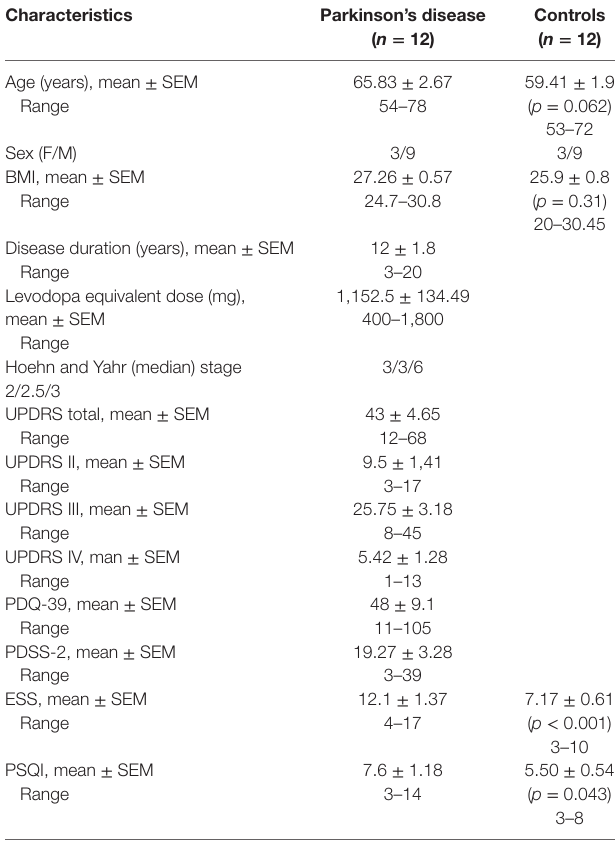
TaBle 1 | Participant’s